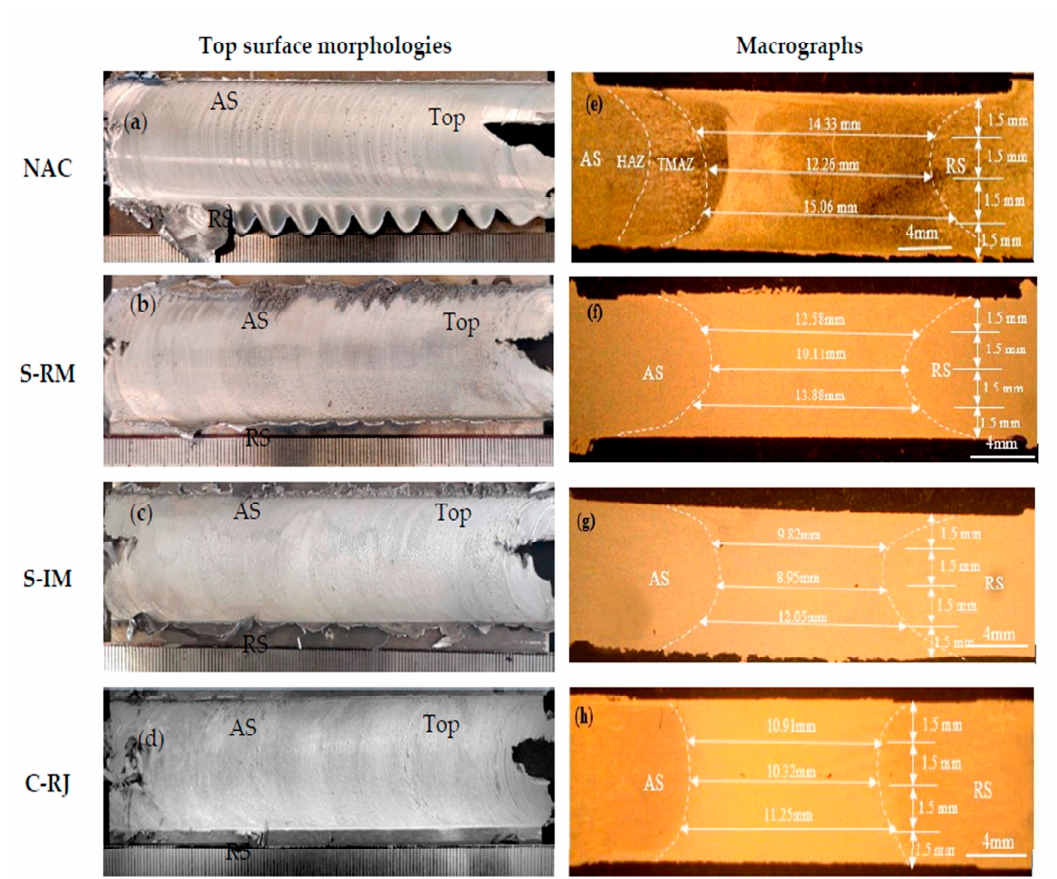
Figure 5. ( a – d ) Top surface morphologies and ( e – h ) macrographs of bobbin tool friction stir welded joints for the different cooling